Question: What kind of plot is shown here?
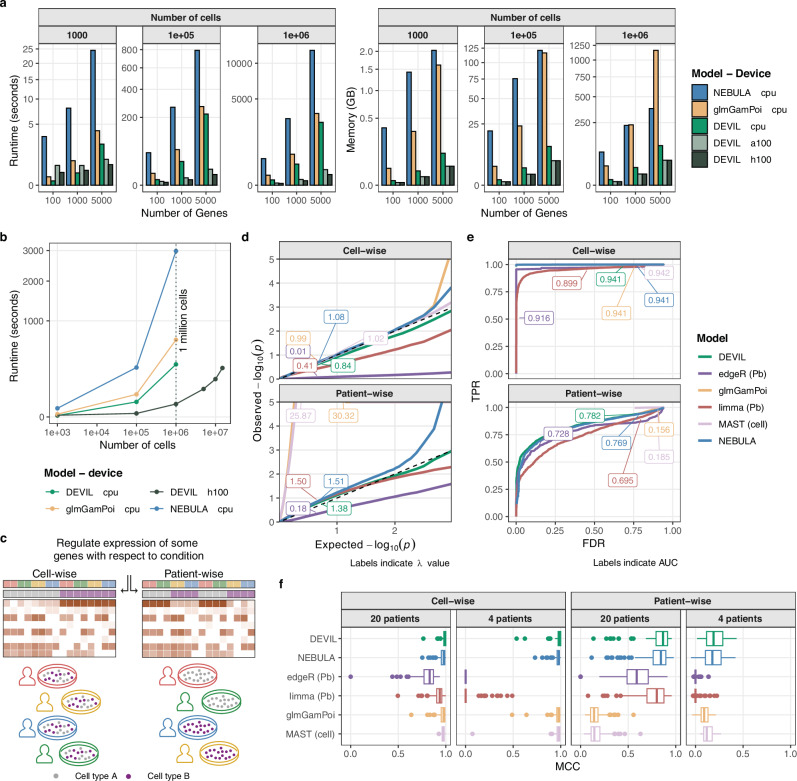
Answer: line